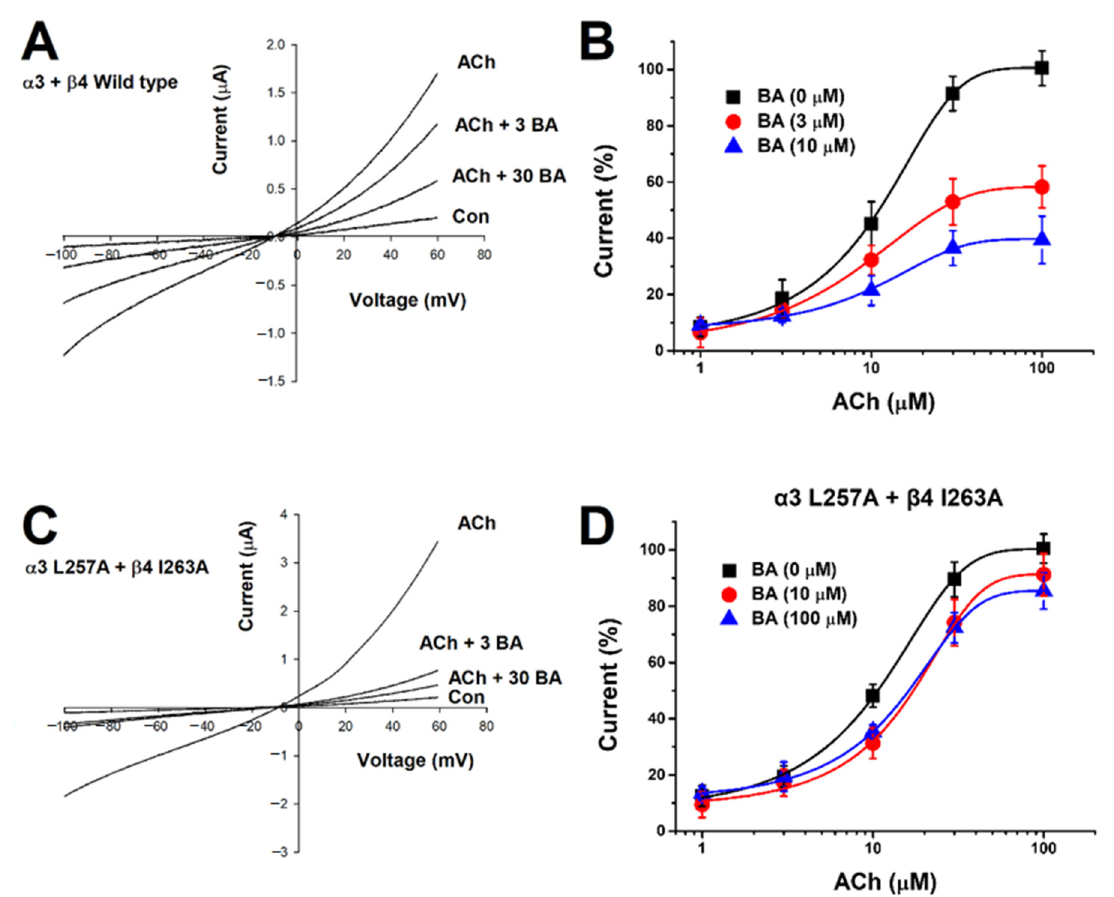
Figure 2. Confirmation of α 3 β 4 nAChRs current-voltage relationship and non-competitive action of BA. ( A ) Confirmation of the interaction between the response of α 3 β 4 nAChRs and different concentrations of BA using a voltage ramp protocol from − 100 to +60 mV. The membrane holding potential was − 80 mV. The applied ACh concentration was fixed at 100 µ M ( n = 8–10 from four different frogs). ( B ) After applying various concentrations of ACh, induced internal current and non-competitive action of BA were observed. The concentration of BA applied was 3 µ M ( • ) or 10 µ M ( (cid:78) ). The holding potential of the oocyte voltage-clamp was − 80 mV. Each point represents mean ± SEM ( n = 7–9/group). ( C ) Double-mutant α 3 β 4 nAChRs ( α 3: L257A, β 4: I263A) and the application of different concentrations of BA using a voltage ramp protocol from − 100 to +60 mV. The membrane holding potential was − 80 mV. The applied ACh concentration was fixed at 100 µ M ( n = 7–9 from five different frogs). ( D ) Applying various concentrations of ACh and BA to double-mutant α 3 β 4 nAChRs ( α 3: L257A, β 4: I263A). The concentration of BA applied was 10 µ M ( • ) or 100 µ M ( (cid:78) ). The holding potential of the oocyte voltage-clamp was − 80 mV. Each point represents mean ± SEM ( n =